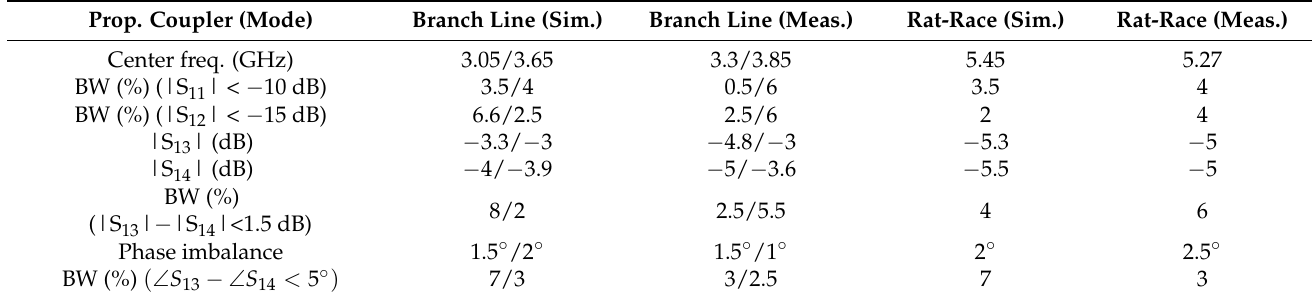
Table 1. Final simulated and measured characteristics of the proposed coupler.